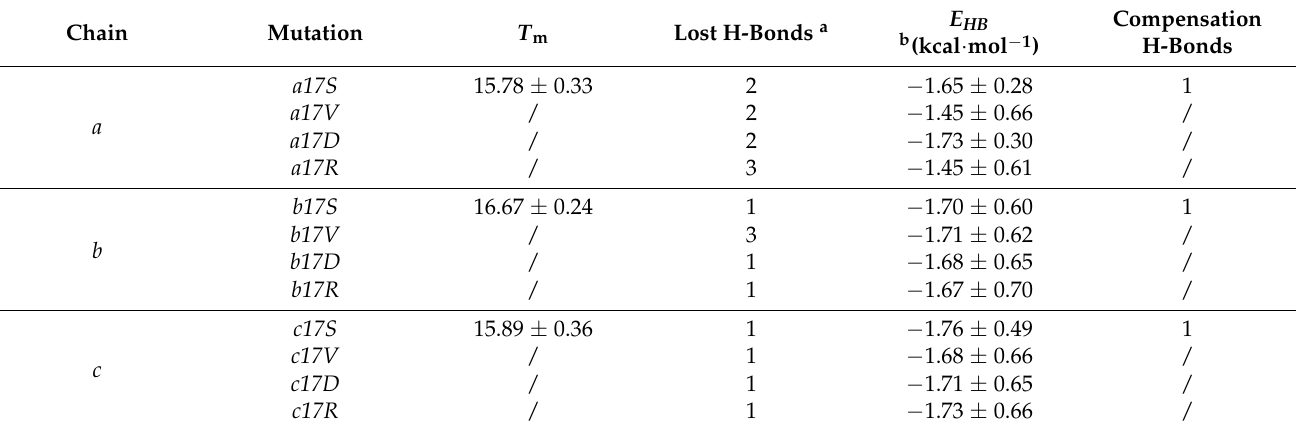
Table 2. Characterizations of different OI model systems.